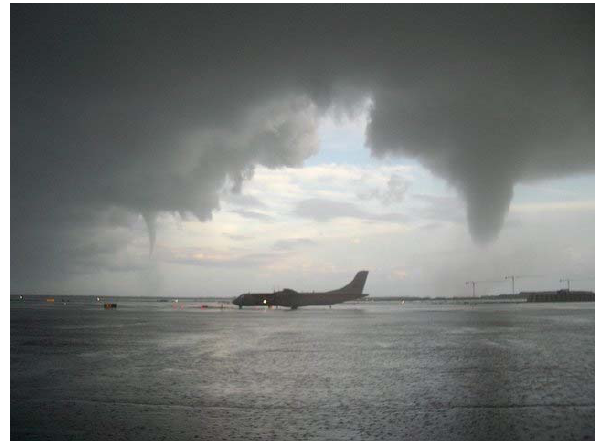
Figure 3. Example of simultaneous occurrence of tornadoes during an event that also recorded heavy rainfalls and floods (Barcelona Airport, Spain).